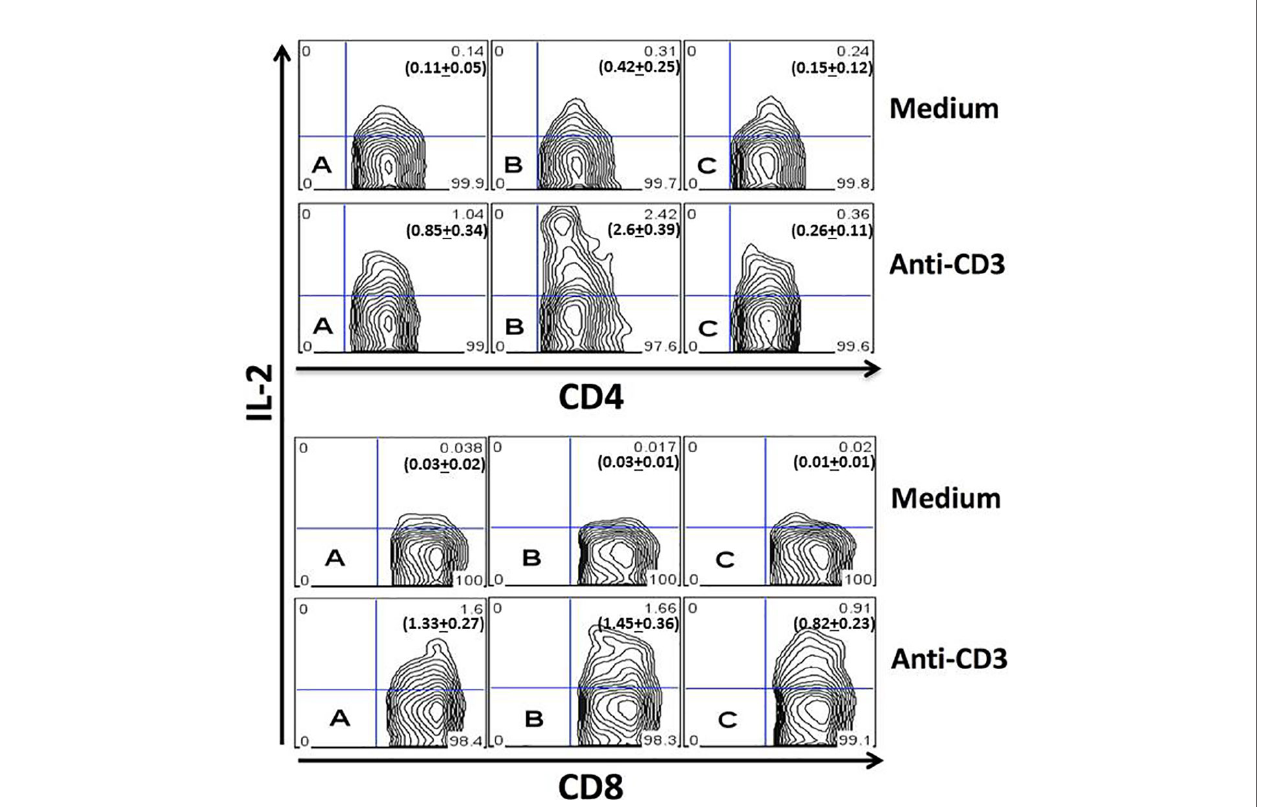
FIGURE 1 | Quantitation of IL-2 production by splenic T cells during acute infection. Spleen cells from uninfected (A) or infected mice obtained on the day fourth (B) and 21th (C) of infection were studied after 24 hours of culture in medium alone (upper plots) or after stimulation with anti-CD3 mAb (lower plots). CD4 + (upper panel) and CD8 + (lower panel) gated T cells are represented. Each plot represents one mouse from the same experiment. Experiments were repeated three times with similar results. P values for IL-2 + CD4 + T cells cultured in medium alone: (A) vs . (B) , P < 0.05; (A) vs . (C) , P > 0.05; (B) vs . (C) , P < 0.05. P values for IL-2 + CD4 + T cells cultured with anti-CD3: (A) vs . (B) , P < 0.001; (A) vs . (C) , P > 0.05; (B) vs . (C) , P < 0.001. P values for IL-2 + CD8 + T cells cultured with anti-CD3: (A) vs . (B) , P > 0.05; (A) vs . (C) , P < 0.05; (B) vs . (C) , P < 0.05. Numbers in bold depicted in the fl ow cytometry plots represent the mean + SD of each group. ANOVA with Tukey-Kramer ’ s post-test was used to compare groups of mice, n=